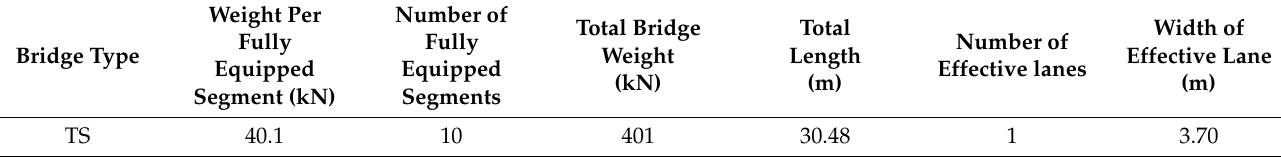
Figure 5. View ( a ) above; ( b ) below the bridge. Table 6. TS bridge dimensions and Table 6. TS bridge dimensions and weight.